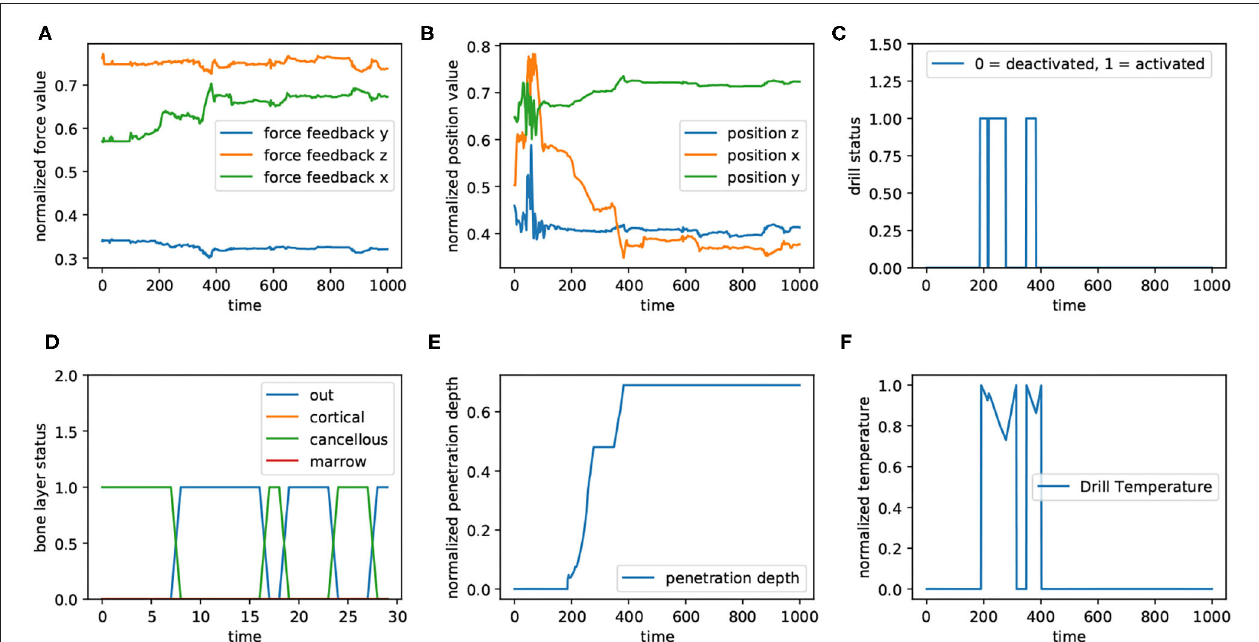
FIGURE 8 | The diagram shows the data captured from different sources in a window of 1,000 data samples. Panels (A,B) show the force feedback and positions, receptively. They have been plotted in 3 dimension (x, y, and z). In addition, all values corresponding to force feedback, positions, drill’s temperature (F) , and penetration depth (E) have been normalized (between 0 and 1). Also, for both drilling status (C) and bone’s layers (D) , 0 denotes “inactivated” and 1 means “activated.” Panel (D) illustrates the layer of the bone, in which drill is located. For a better visualization in this subplot, the 30 first data corresponding to the aforementioned window are